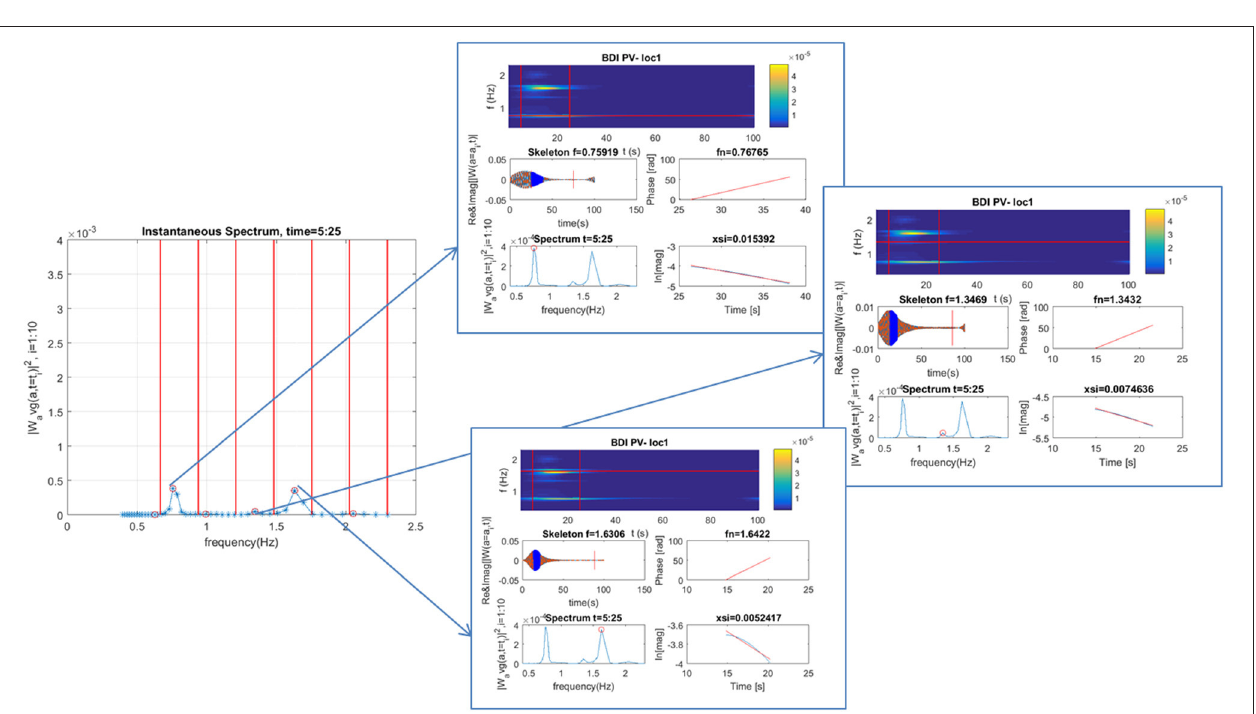
the dominant frequencies in a given frequency region, is used to control the sensor locations that are selected for analysis. If the coefficient of determination for the linear fit used to identify the frequency is below the pre-defined threshold, the